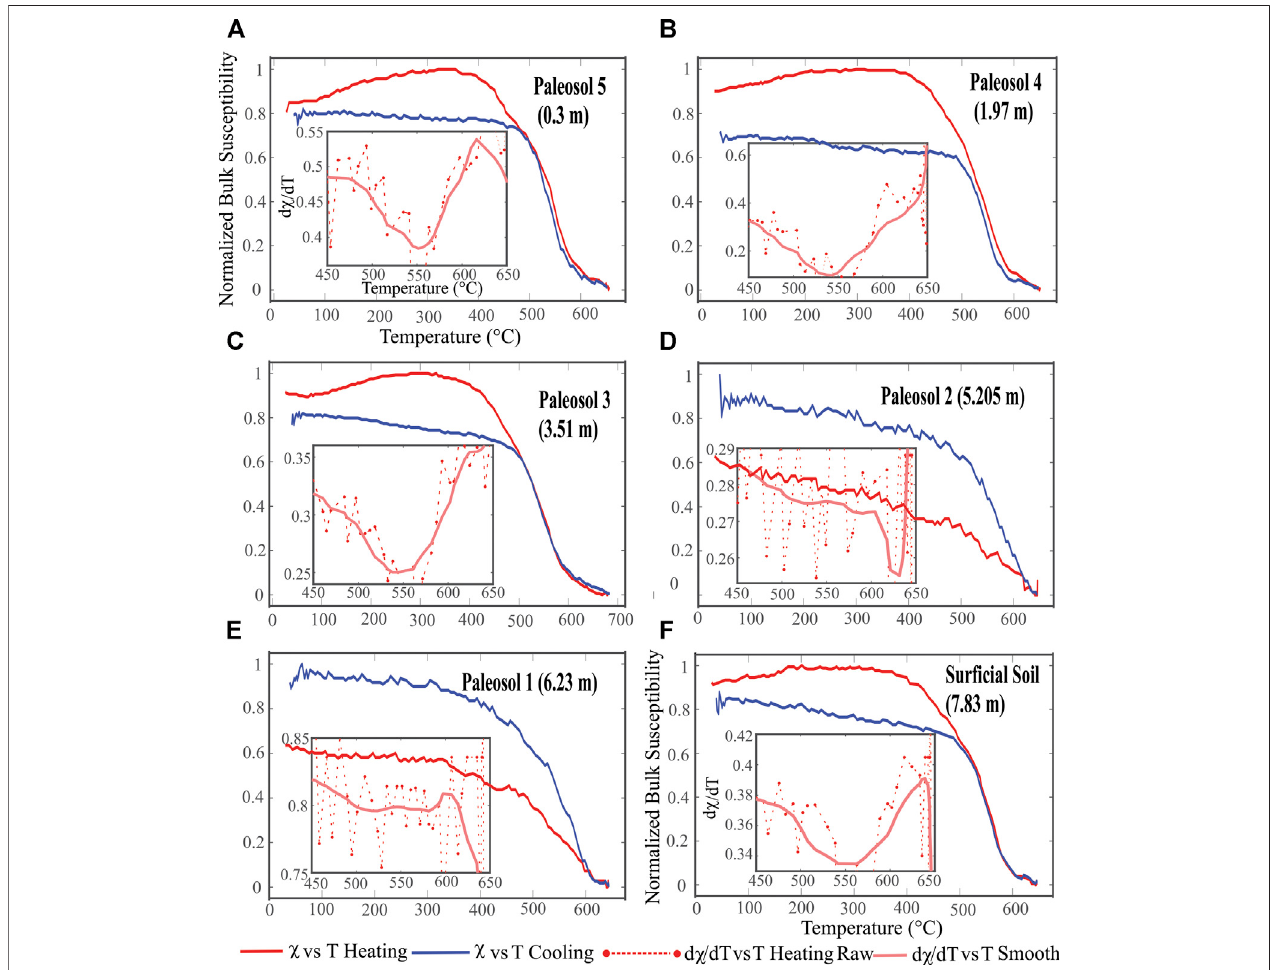
FIGURE6| Resultsofbulkmagneticsusceptibilityvsheating/cooling(red,bluerespectively)experimentsforrepresentativesamplesfromallsoilhorizonsidenti fi ed intheBDF forPaleosol5(6a),Paleosol4(6b),Paleosol 3(6c),Paleosol 2(6d), Paleosol1(6e),andtheSur fi cialSoil (6f).Thederivative ofbulkmagneticsusceptibilitywith respect to temperature (d χ /dT) is inset in the bottom left of each graph. The red-dashed lines represents the raw d χ /dT, while the light reddish-pink line represents the smoothed model, which was created in order to highlight the general trends. In general, the smoothed d χ /dT shows Curie temperatures of ∼ 540 ° -560 ° C indicates the presence oflow-Ti magnetite and or partiallymaghemitized magnetite (Tarling, 1983; Maher and Thompson, 1999; Hanesch et al., 2006).Loss of susceptibility after heating is interpreted to represent the inversion of maghemite into hematite (Dunlop and Özdemir, 1997).